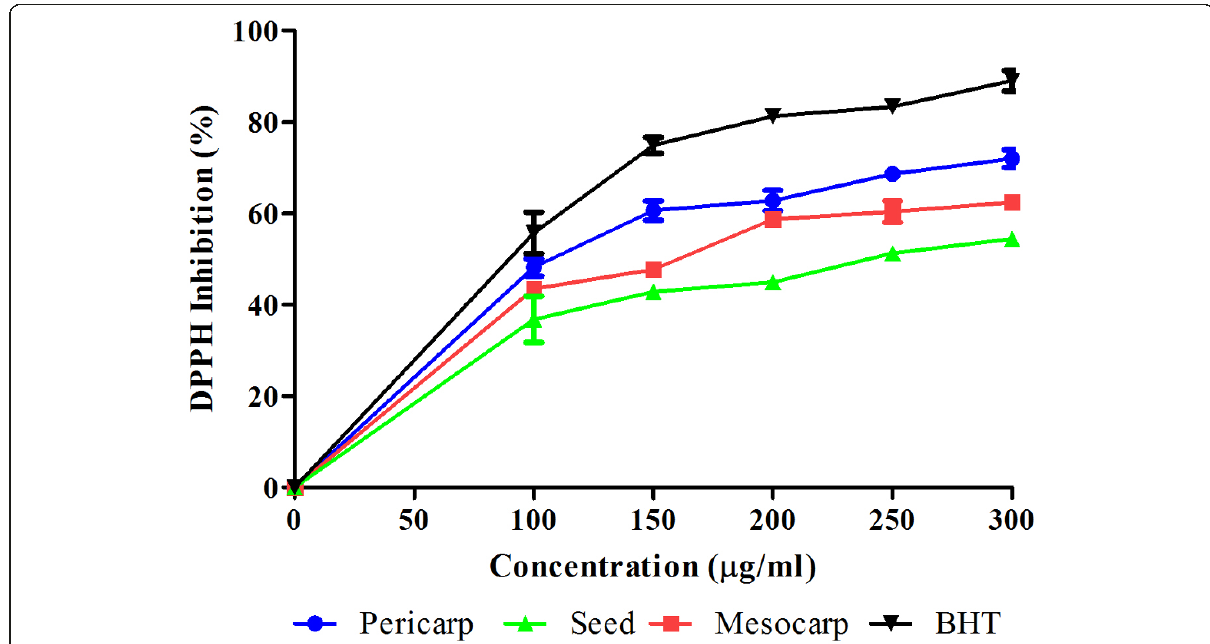
Figure 3 Free radical scavenging activity of extracts at different concentrations . Values are mean ± S.E.M. of three experiments.